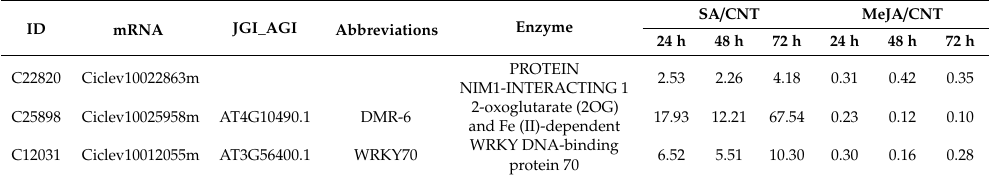
Figure 7. Effects of salicylic acid (SA) and methyl jasmonate (MeJA) treatments on the expression of CitWRKY70 in the juice sacs of Satsuma mandarin in vitro. The mRNA levels were analyzed by TaqMan real-time RT-PCR, and the expression of 18S ribosomal RNA (rRNA) was used as a control to normalize the raw data. Columns and bars represent the means and SE ( n = 3), respectively. Different letters indicate significant differences at the 5% level by Tukey’s HSD test. WRKY70 , WRKY DNA-binding protein 70. Table 1. Details of three genes that were more than 2-fold upregulated in salicylic acid (SA) treatment and 2-fold downregulated in methyl jasmonate (MeJA) treatment. CNT,